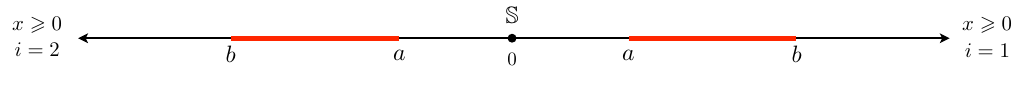
Figure 1 . The bipartition of the line mainly considered in this manuscript: two disjoint equal intervals with length b − a separated by a distance 2 a , placed symmetrically with respect to a point-like defect described by the scattering matrix S